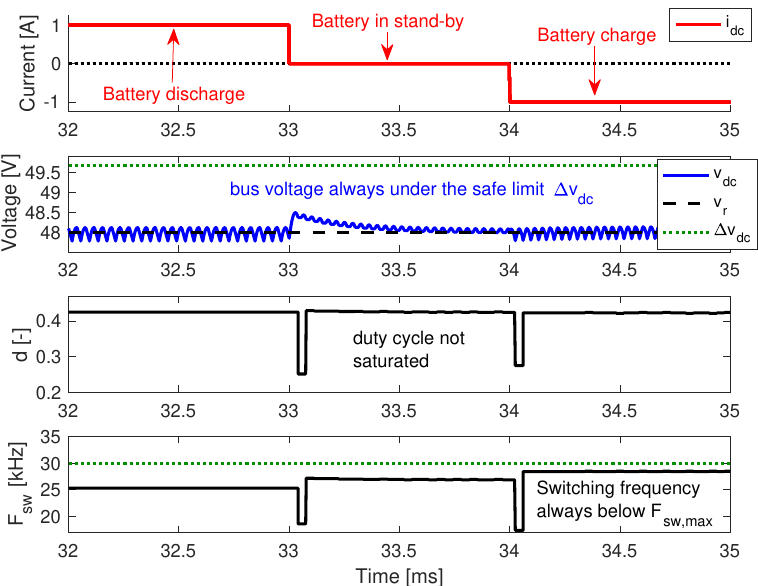
Figure 15. Transition between battery discharge, battery charge, and battery in